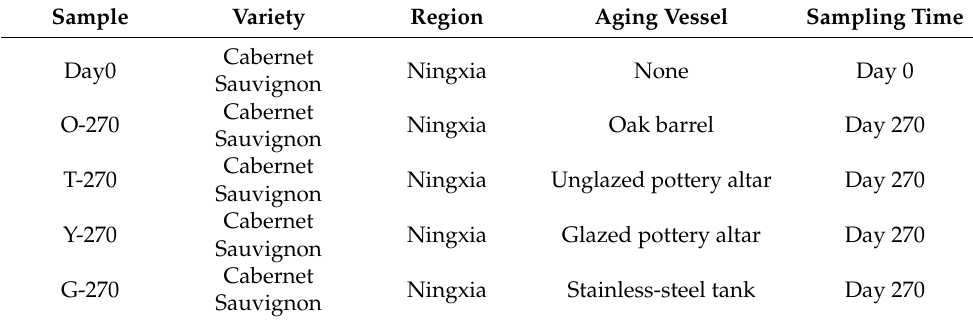
Table 1. Red wine